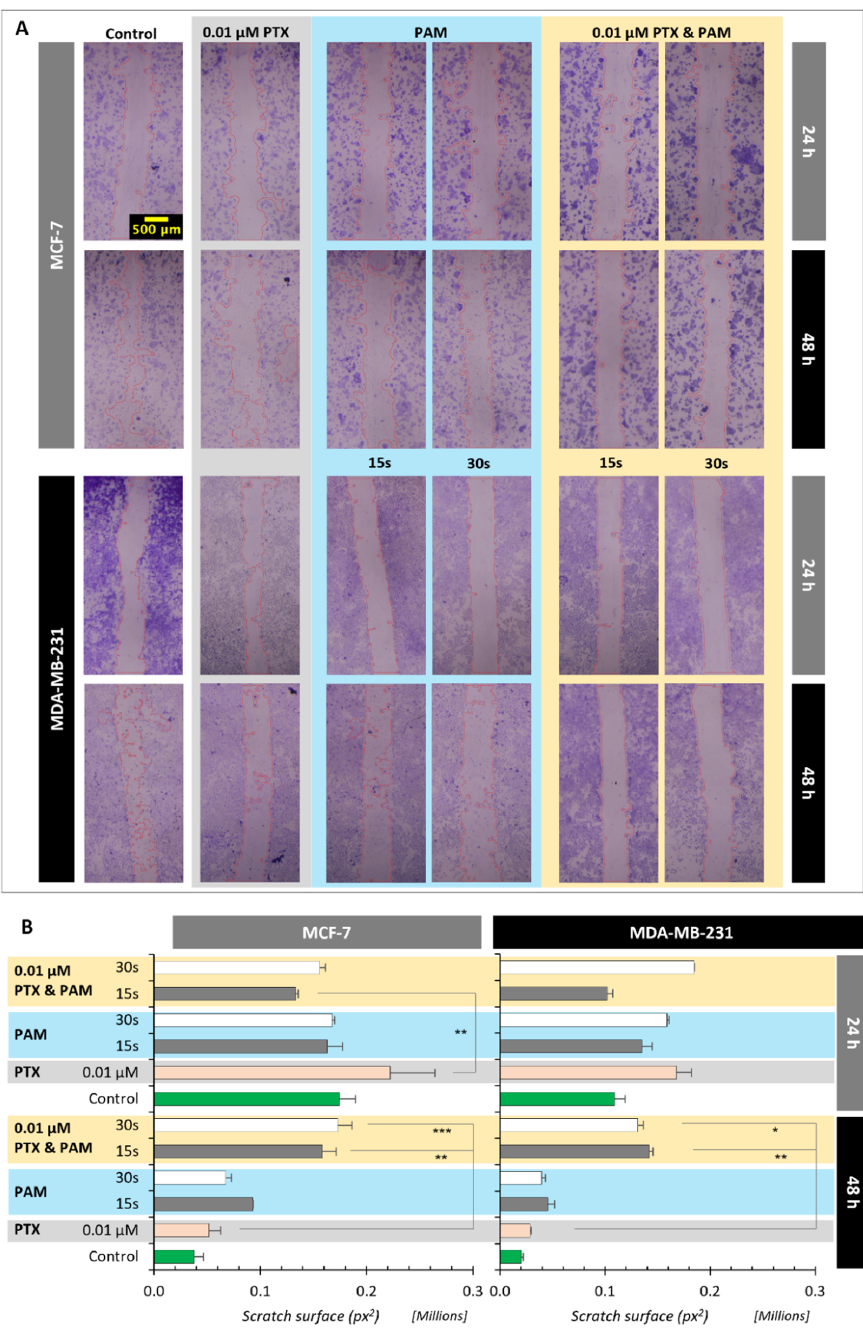
Figure 6. ( A ) Effect of PAM, PTX, and combined treatment on cell migration of MCF-7 and MDA-MB-231 cells, representative images (all images have the same scale as shown in MCF-7 control image, 500 µm). Confluent layers of both cell lines were scratched, and the growth media were exchanged with corresponding media containing PTX and PTX and PAM, while for the control group only fresh complete media were added. Migration of MCF-7 and MDA-MB-231 cells was assessed by taking photos in the same spot at 24 and 48 h ( n = 3) after the treatment was applied. The baseline was chosen as the initial area delimited by the margins of the scratch, before the treatment was added. The 0.01 µ M PTX and PAM 15 s and 0.01 µ M PTX and PAM 30 s significantly decreased migration to 48 h ( p < 0.05, p < 0.01). ( B ) The computed results are presented as mean ± SEM values for 3 independent tests ( n = 3). The statistical significance was established by comparative analysis of the treated groups against PTX using one-way analysis of variance followed by the Tukey post hoc test. * p < 0.05, ** p < 0.01, *** p <